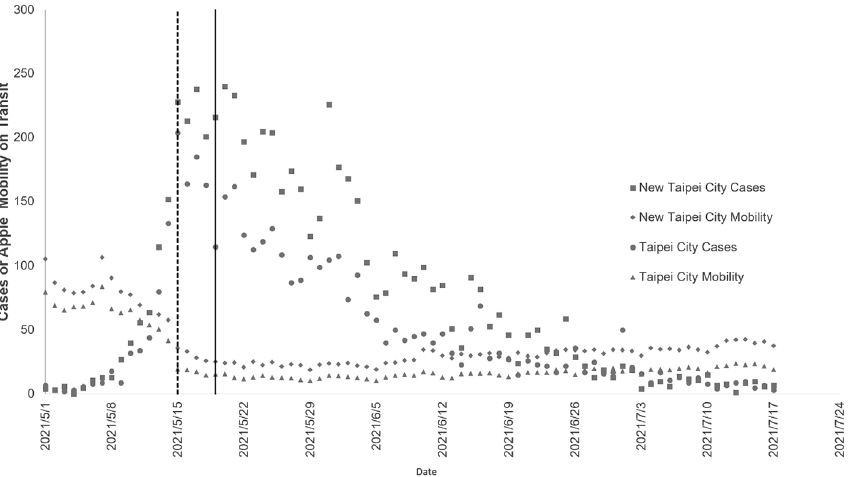
Figure 5. Association between daily COVID-19 cases and Apple mobility indicator on transit in Taipei and New Taipei City. The left vertical dashed line is the level three alert in Taipei and New Taipei City on May 15, 2021. The right vertical solid line is the level three alert throughout Taiwan on May 19, 2021.